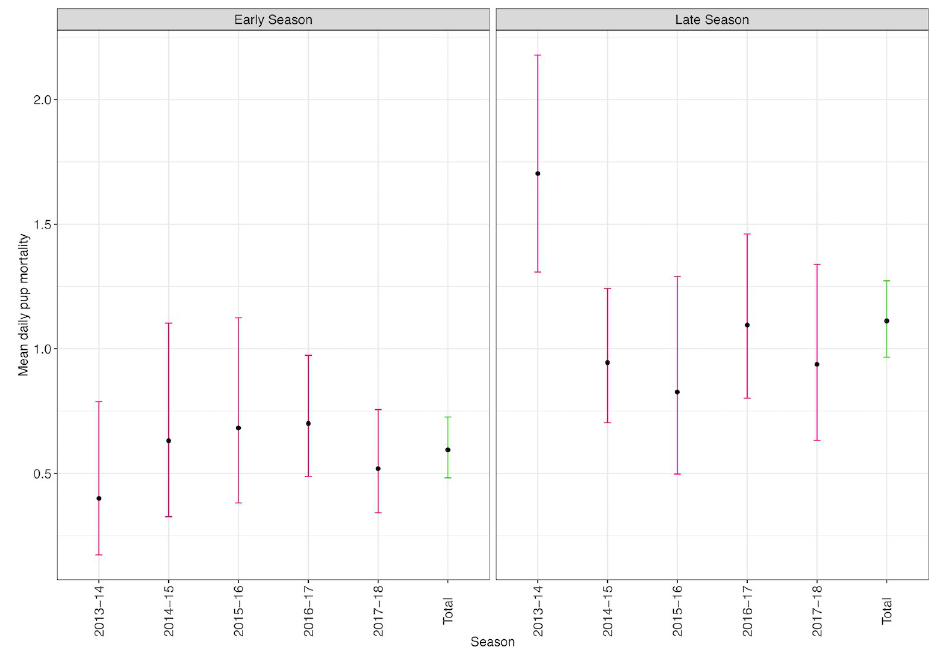
Fig 3. Mean annual daily mortality rate and 95% confidence intervals for New Zealand sea lion ( Phocarctos hookeri ) pups at Enderby Island for early and late season periods when the observed field season is divided at 30 January.